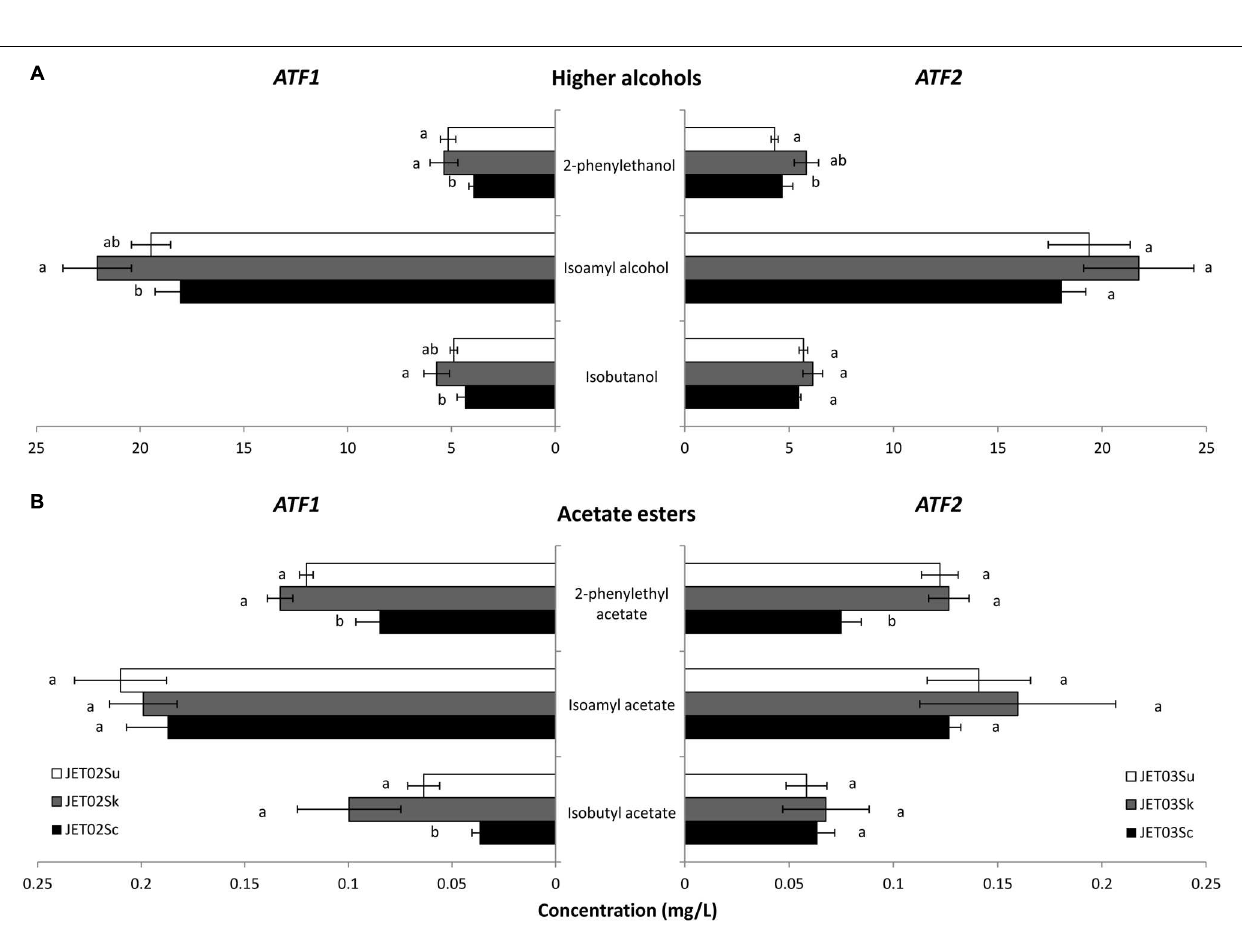
Frontiers in Microbiology |